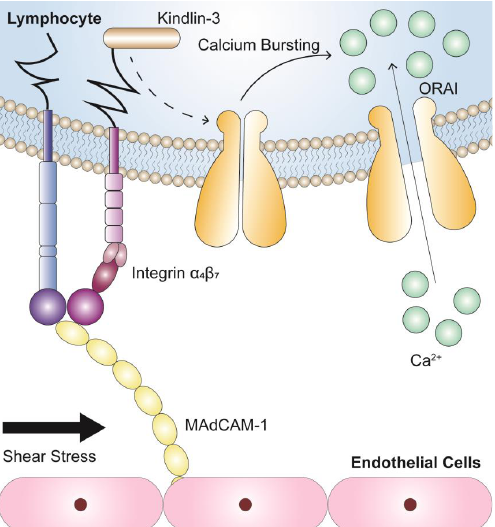
Figure 7. Potential mechanism of calcium signaling for circulating lymphocytes induced by the interaction between integrin α 4 β 7 and MAdCAM-1. Integrin α 4 β 7 engagement of MAdCAM-1 induces the force-dependent calcium signaling of firmly adhered RPMI 8226 cells in flow through a common pathway, in which Kindlin-3 is required, to subsequently activate calcium influx. Author Contributions: Conceptualization, D.S. and Q.L.; methodology, D.S. and Q.L.; investigation, D.S., Z.L., Y.K. and R.H.; data curation, D.S.; writing — original draft preparation, D.S.; writ- ing — review and editing, Q.L.; supervision, Q.L.; and funding acquisition, Q.L. All authors have read and agreed to the published version of the manuscript.